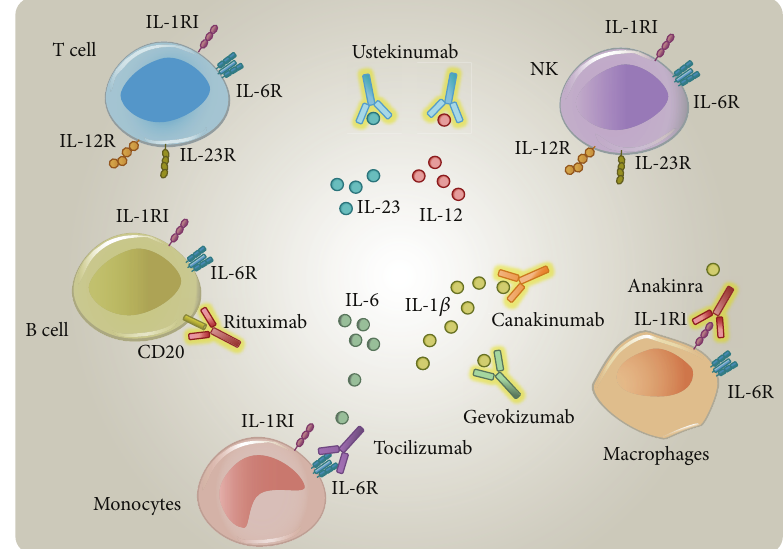
Figure 1: Mechanisms of actions of anakinra, canakinumab, gevokizumab, tocilizumab, ustekinumab, and rituximab, based on the different mechanisms of antagonizing cytokine receptors, cytokines, and cellular